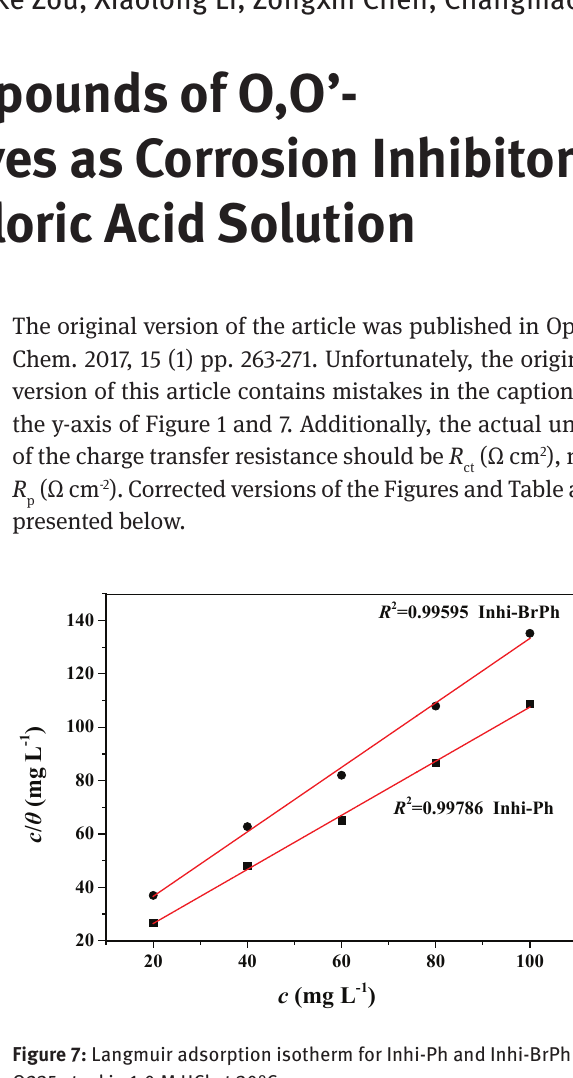
Figure 1: Infrared spectra of Inhi-Ph and Inhi-BrPh. Figure 7: Langmuir adsorption isotherm for Inhi-Ph and Inhi-BrPh on Q235 steel in 1.0 M HCl at 30°C.